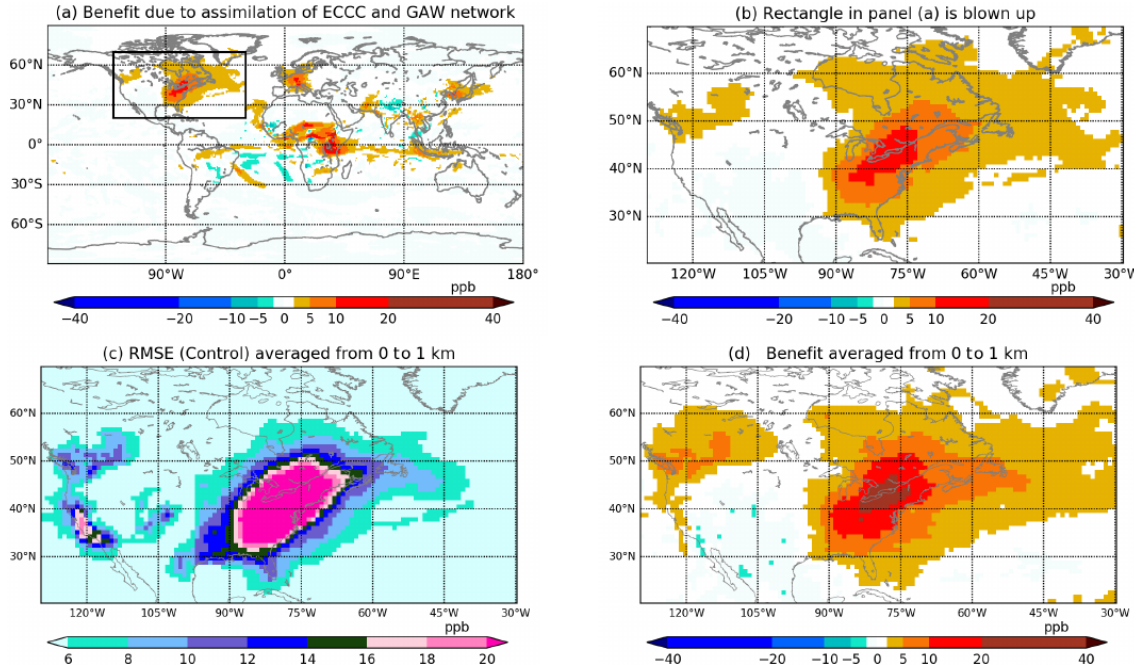
Figure 10. In all panels, the averages from 10 January 2015 at 18:00:00UTC to 28 February 2015 at 00:00:00UTC are shown: (a) column (0– 5km) mean benefit from EXP_GAW ; (b) the North American domain from panel (a) ; (c) column (0–1km) mean RMSE from EXP_CNTRL ; and (d) column (0–1km) mean benefit from EXP_GAW